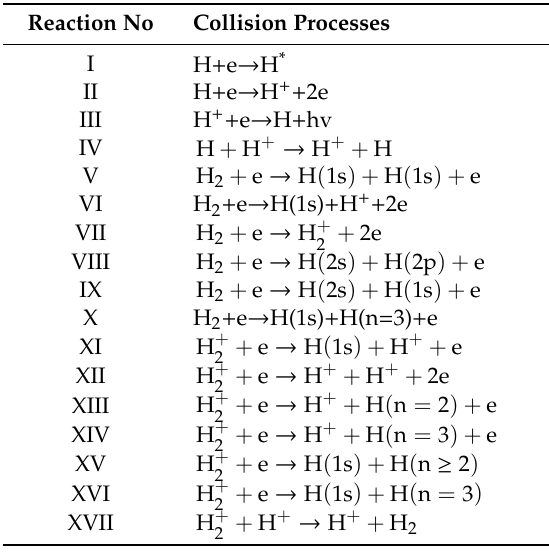
Table 1. The atomic and molecular reactions by electron and proton impact which have included in present